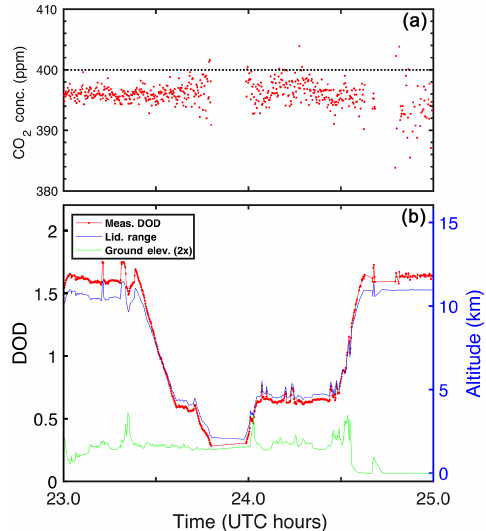
Figure 14. Lidar measurement and retrieval results from 2014 SF2 flight over Edwards AFB, CA, on 22 August 2014. From the ∼ 11km altitude, the aircraft flew a spiral-down pattern to near the Edwards Dry Lake Bed. (a) The retrieved XCO 2 values from the lidar measurements, with each dot made using 10s averaging time. (b) Time-resolved results showing the lidar-measured differential optical depth, the range to the surface and the computed surface elevation. The lidar-measured range to the scattering surface and the scattering surface “ground” elevation are plotted against the right- hand axis. The upward spikes in the DOD and range are from the slant paths during the banking of the aircraft during the corners of the box